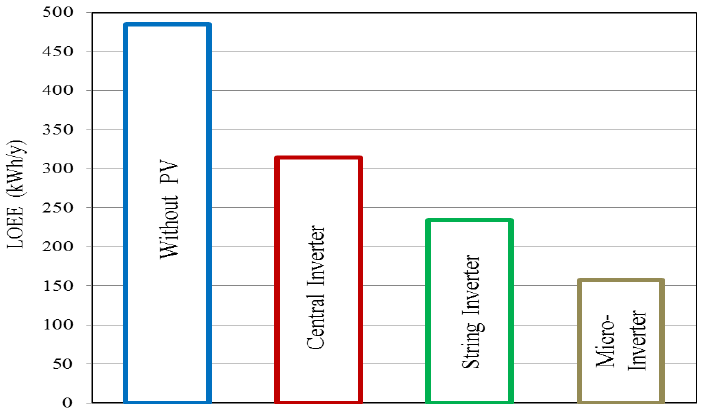
Figure 14. System Adequacy for Different PV Topologies.